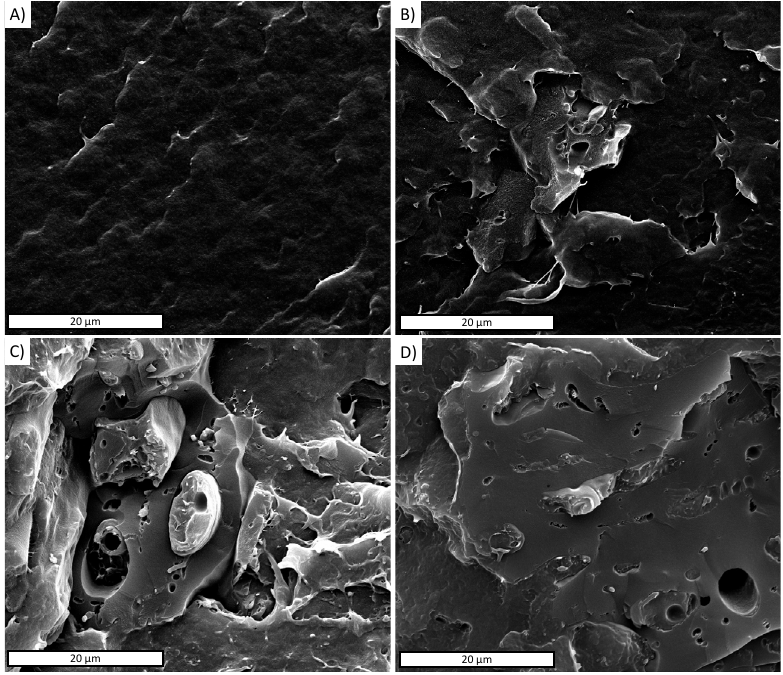
Figure 3. SEM micrographs of ( A ) biochar particles and ( B ) PBAT nitrogen-fractured surface.